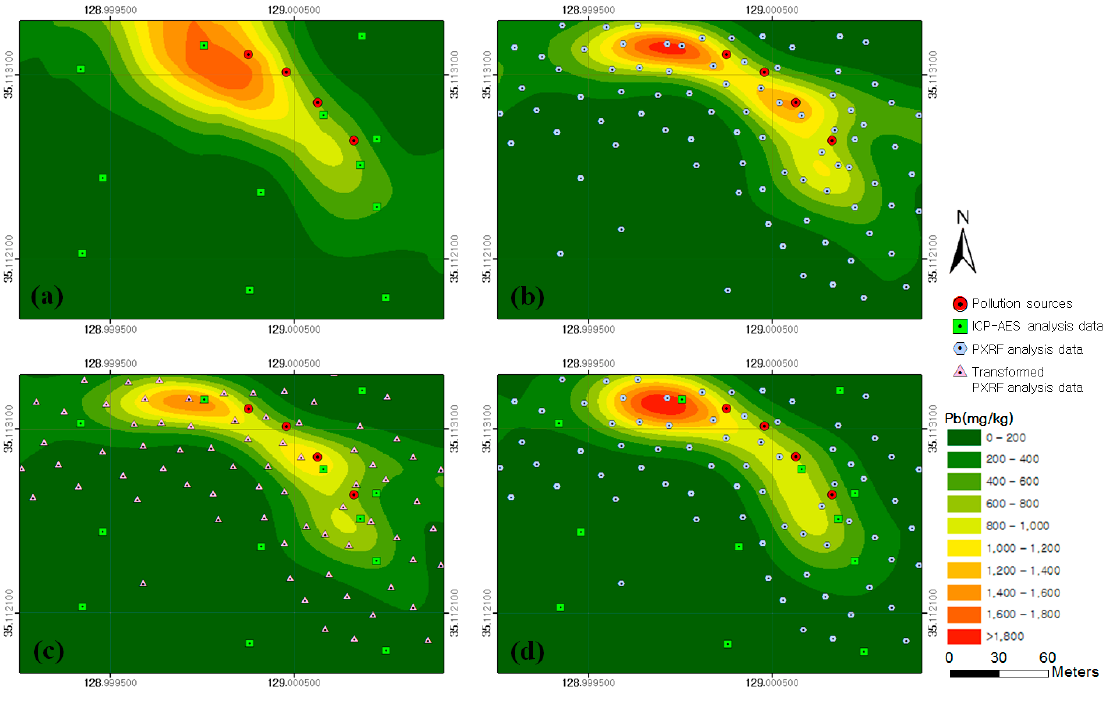
Figure 7. Soil contamination maps for lead generated by approaches: ( a ) 1; ( b ) 2; ( c ) 3; and ( d ) 4.